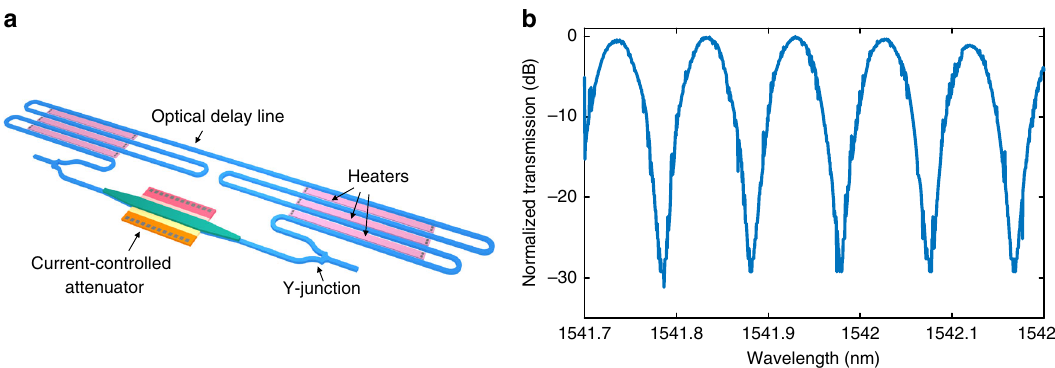
Fig. 3 The implemented electronically recon fi gurable Mach − Zehnder interferometer. a The structure of the implemented recon fi gurable Mach − Zehnder interferometer (MZI). The delay difference between the two arms is about 80 ps. The loss mismatch can be compensated using the p-doped-intrinsic-n- doped structure acting as a current-controlled attenuator. The relative phase between the two arms can be adjusted using p-type polysilicon heaters placed between the waveguides of the delay line. b The measured transmission spectrum of the integrated MZI. The free spectral range of 0.1 nm and an extinction ratio of 28 dB were measured. The measurement details and the characterization setup are included in Supplementary Note 3 and Supplementary Fig. 4, respectively